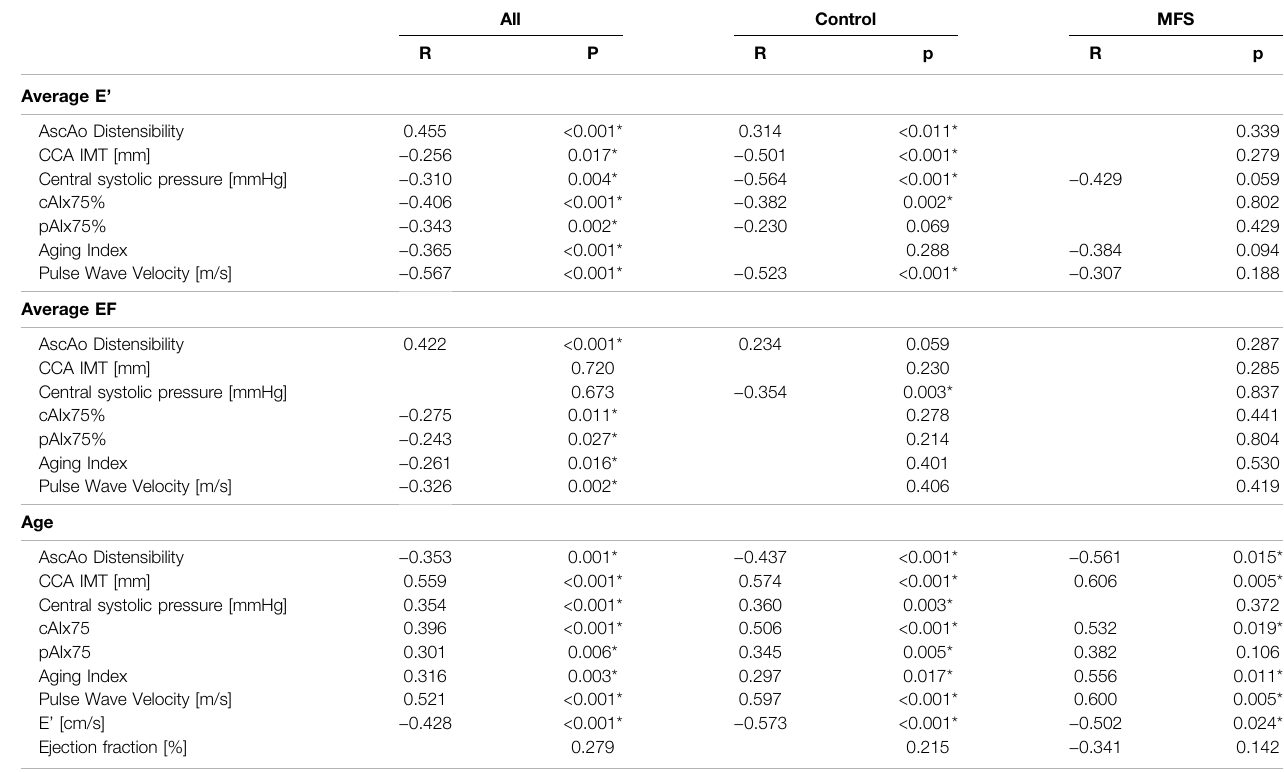
TABLE 3| Correlations between cardiovascular characteristics and average E ’ (diastolic function),EF (systolic function), or age for all patients aswell asgroup-wise analysis for controls and MFS patients. All